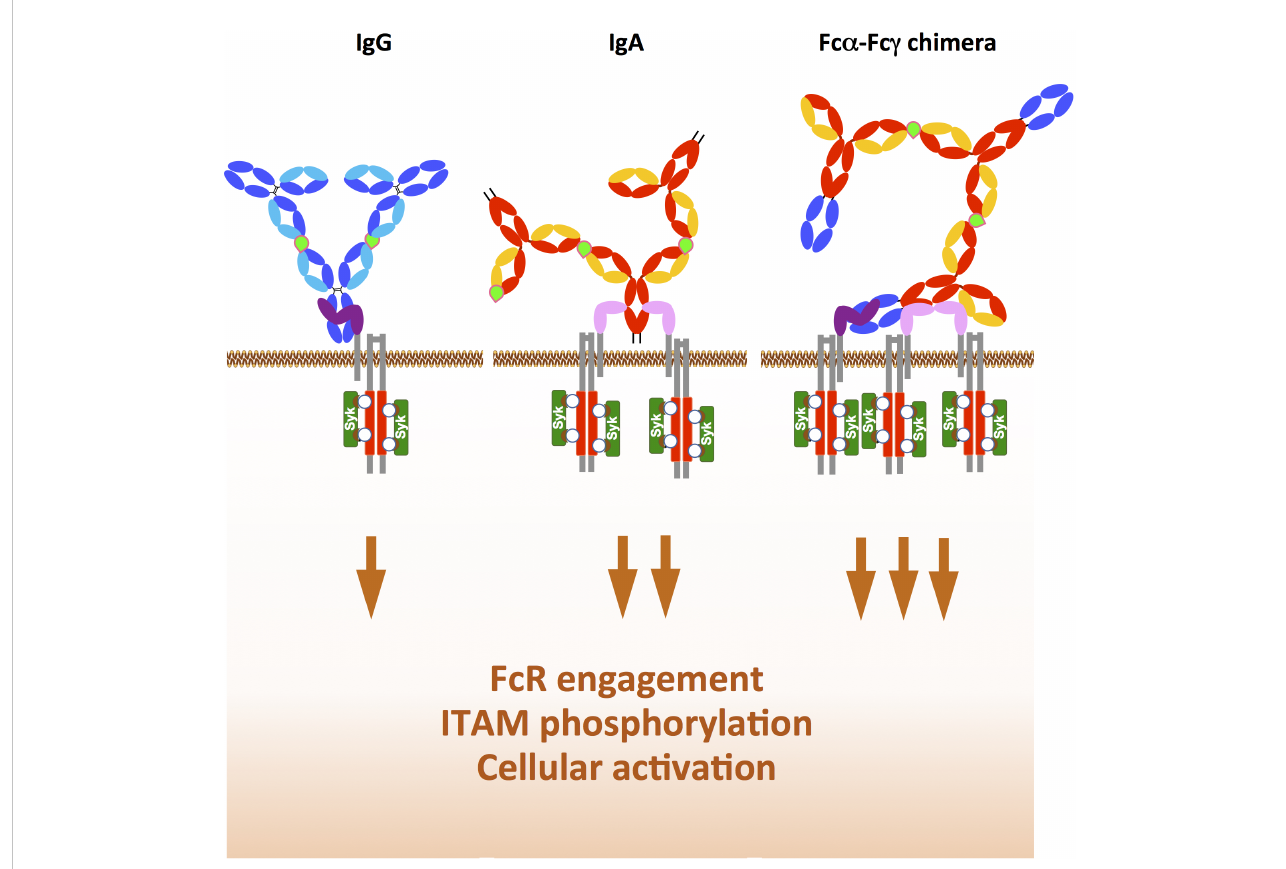
FIGURE 5 Rationale for the development of chimeras with Fc a and Fc g expressed in tandem. While IgG in immune complex with antigen (light green) binds only to one Fc g RI/CD64 (left) and the IgA immune complex binds to two Fc a RI/CD89 (middle), the Fc a -Fc g chimera immune complex binds simultaneously to one Fc g RI/CD64 and two Fc a RI/CD89, This increases downstream ITAM (red) phosphorylation (white circle) and subsequent Syk recruitment (dark green), thereby enhancing the functions of immune effector cells such as ADCC and